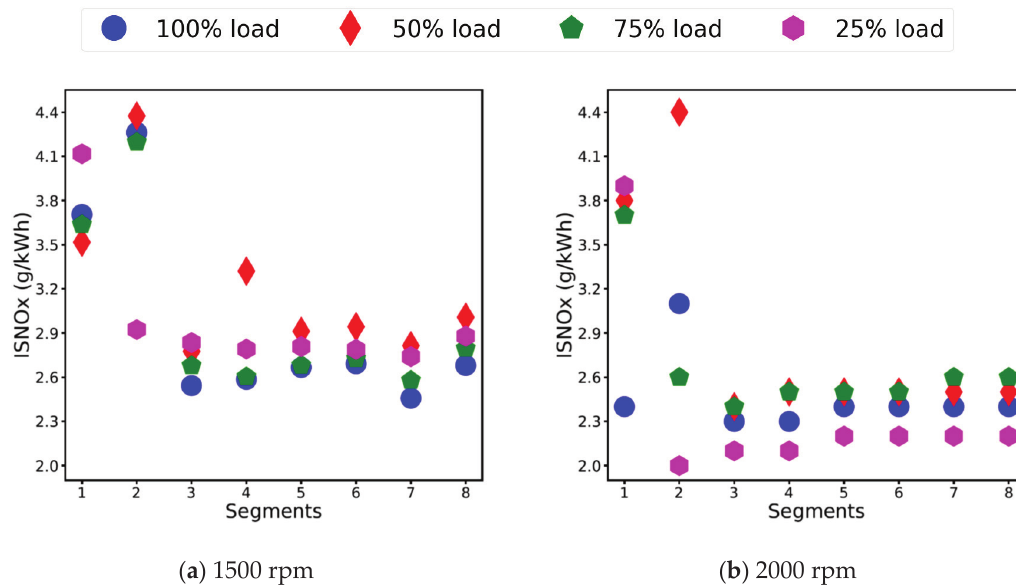
Figure 15. NOx emissions (g/kWh) at each load in each segment at ( a ) 1500 and ( b ) 2000 rpm. The blue circle represents 100% load, the red diamond 50% load, the green pentagon 75% load and the pink hexagon 25% load.